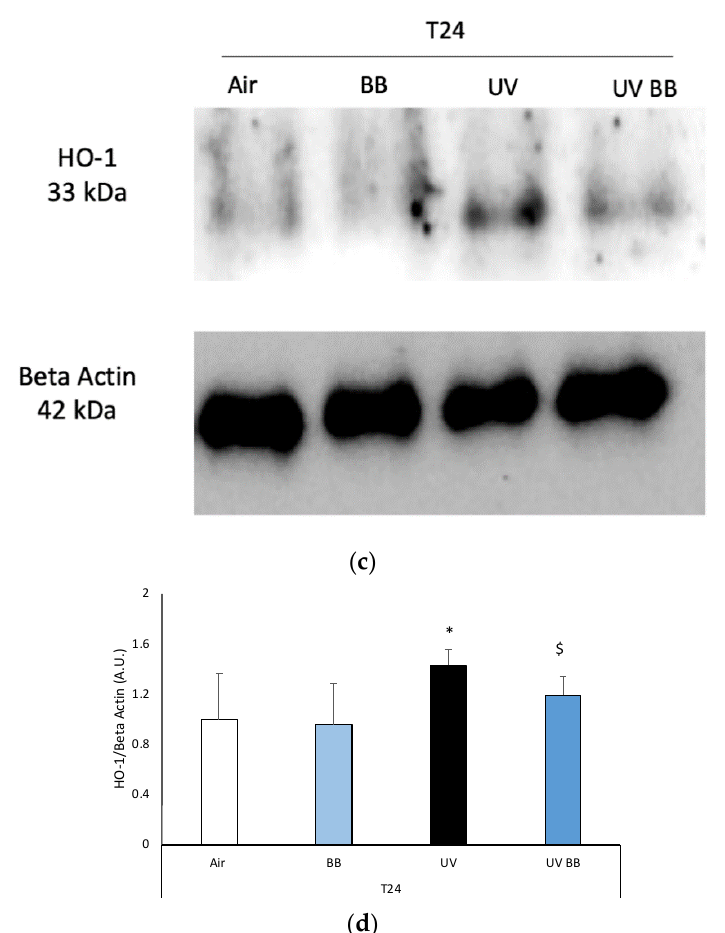
Figure 3. Skin exposure to UV induces peroxidative damage (4HNE, HO-1), however, pre-treatment with BB extract prevents this oxidative damage. Ex vivo human skin biopsies were untreated or pre-treated with BB and then exposed to 200 mJ of UVA/UVB, following 4HNE, and HO-1 protein levels were evaluated. ( a ) Green fluorescence staining represents 4HNE-protein adduct levels at the original magnification 40×. ( b ) Semi-quantification of 4HNE green fluorescence intensities performed with ImageJ are depicted in the histogram panel. ( c ) HO-1 protein levels measured via Western blot assay at 24 h (T24) upon UV exposure. ( d ) Relative quantification of HO-1 protein levels measured by ImageJ. Data are expressed as arbitrary units (average of three independent experiments), * p < 0.05 Air vs. UV; $ p < 0.05 UV vs. UV BB by ANOVA. Scale bar 100 μ m.